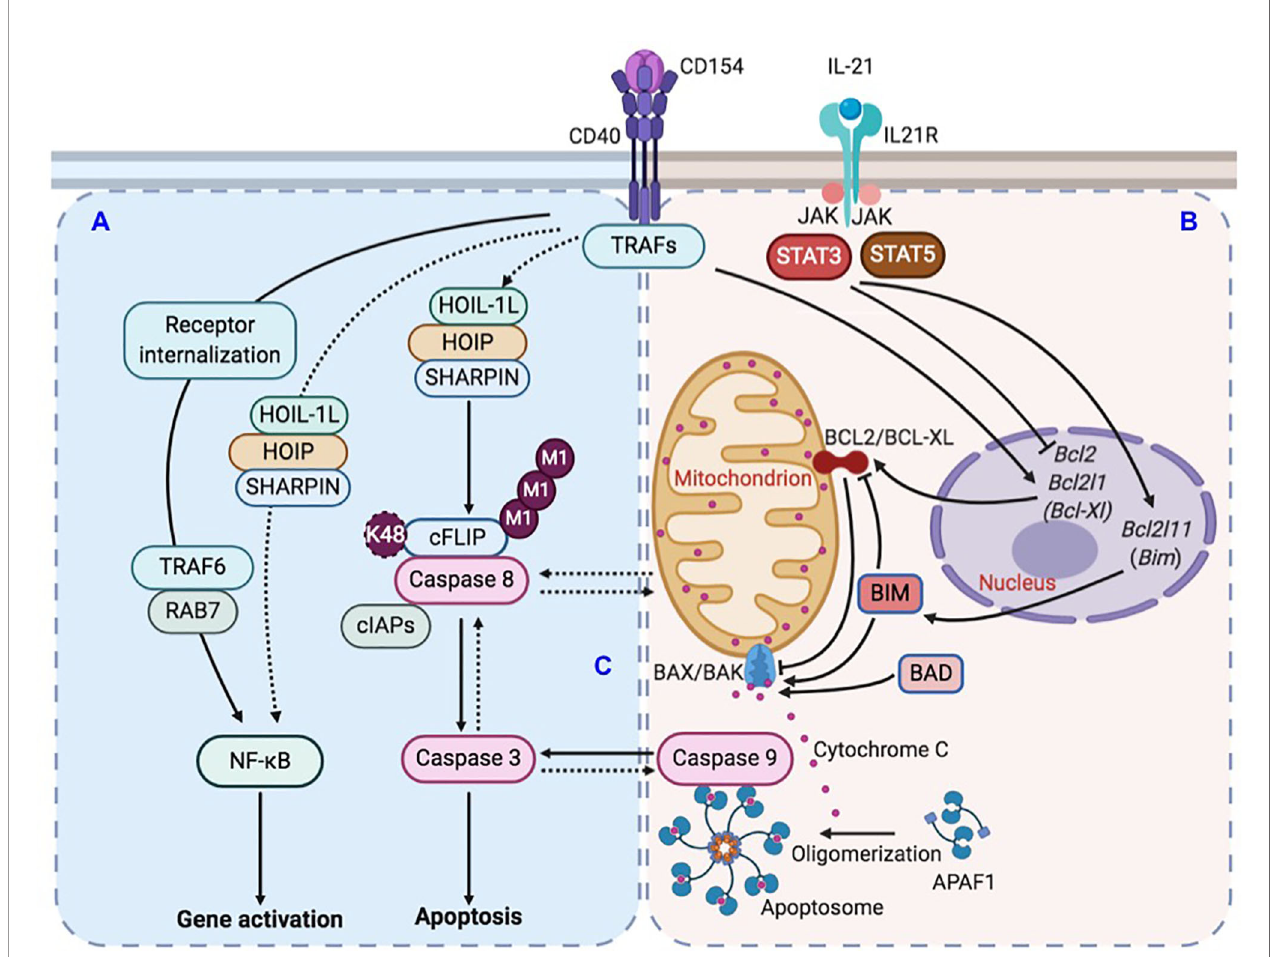
FIGURE 9 | Illustration of LUBAC-mediated suppression of IL-21-induced apoptosis in CD154-stimulated B cells. (A) CD40 activation in B cells upregulates LUBAC-catalyzed linear M1-Ub, including that of cFLIP, which leads to cFLIP stabilization and inhibition of caspase 8 activation. LUBAC plays a minor role to the major role of RAB7 in CD40-triggered NF- k B activation in B cells. (B) CD40 activation also induces the expression of anti-apoptotic factor BCL2 and BCL-XL. IL-21, however, dampens such induction and also upregulates expression of pro-apoptotic factor BIM. The combined effects of BCL2/BCL-XL downregulation and BIM upregulation would activate pro-apoptotic BAX/BAK complex to increase the mitochondria permeability and cytochrome C release into the cytoplasm to activate caspase 9. (C) In the absence of LUBAC, caspase 8 activation would amplify a putative caspase network, within which multiple caspases, including caspase 9 and caspase 3, would be activated in a synchronized manner due to positive-feedback loops, leading to the irreversible apoptosis